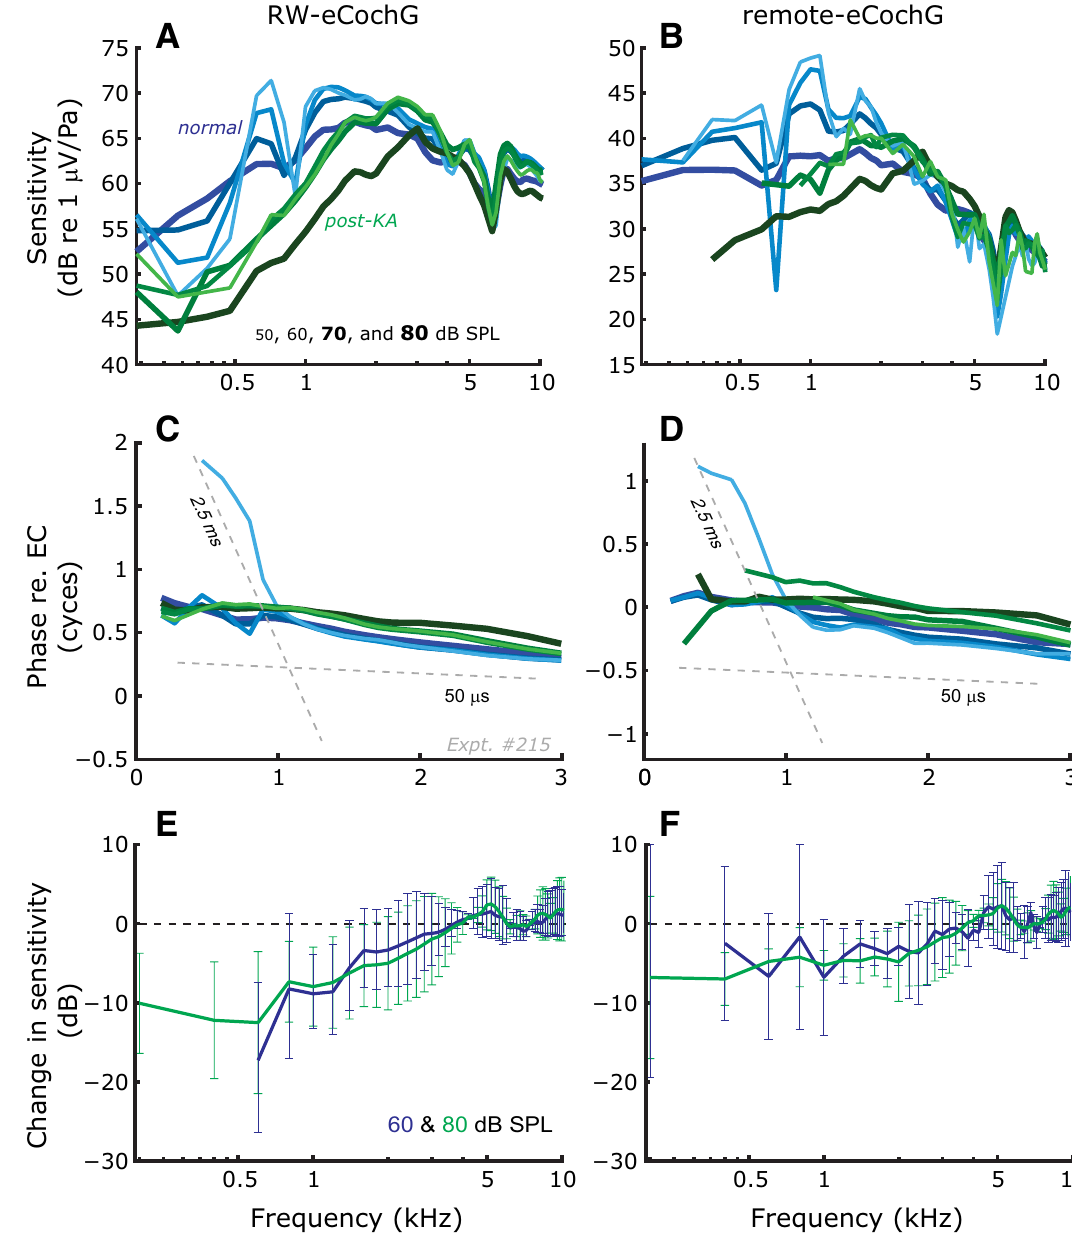
Figure 3. Effects of kainic acid (KA) on RW- and remote-eCochG. Representative examples (Expt. #215) of eCochG sensitivity ( A , B ) and phase ( C , D ) before ( blue lines ) and after ( green lines ) the application of KA to the round window antrum. Dashed lines in panels ( C , D ) indicate delays of 2.5 and 0.05 ms, respectively. ( E , F ) Average change in eCochG sensitivity (n = 5 animals) after KA application at stimulus levels of 60 ( blue lines ) and 80 dB SPL ( green lines ), respectively. Error bars denote ± 1 standard deviation